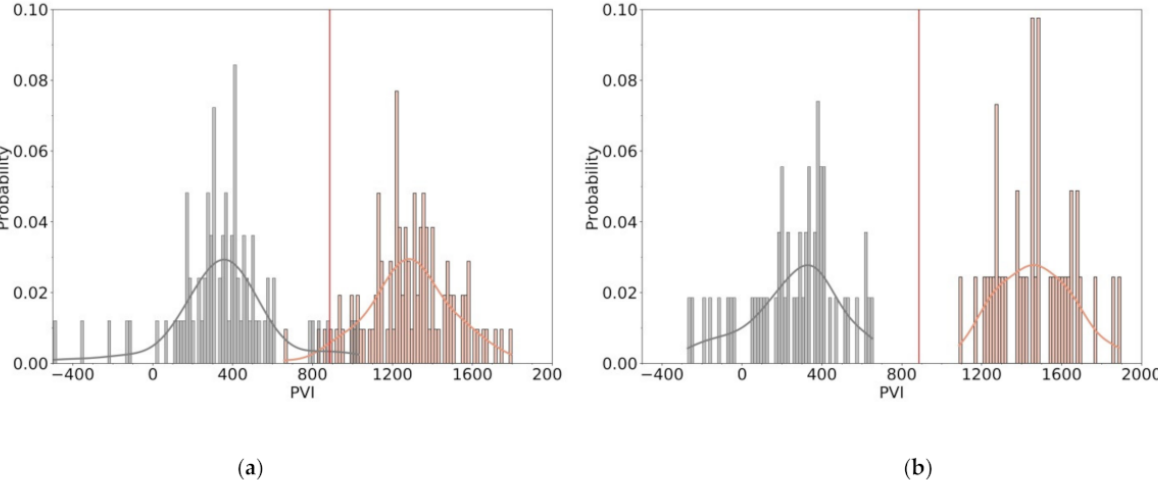
Figure 8. The frequency histograms of PVI values distribution of bare soil and grassland classes: ( a ) sample points; ( b ) control